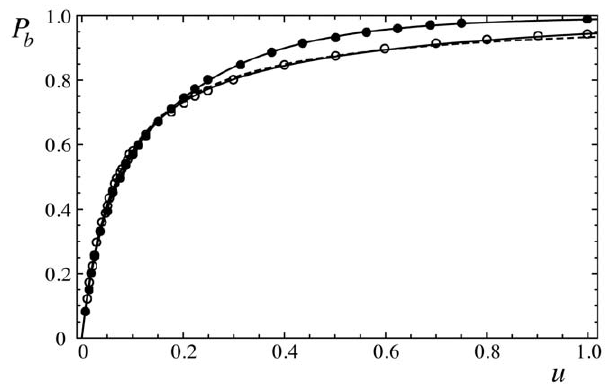
Figure 2. Fraction P b of membrane patches inside a single well as a function of the rescaled depth u of the well. The data points are from Monte Carlo simulations with the rescaled well widths z we ~ 0 : 5 (filled circles) and z we ~ 1 (open circles). The full lines result from fits of the three-parameter function P (3) ( c 1 z u z c 2 u 2 z c 3 u 3 ) with c 1 ^ 0 : 073 , c 2 ^ { 0 : 99 , and c 3 ^ 6 : 44 for